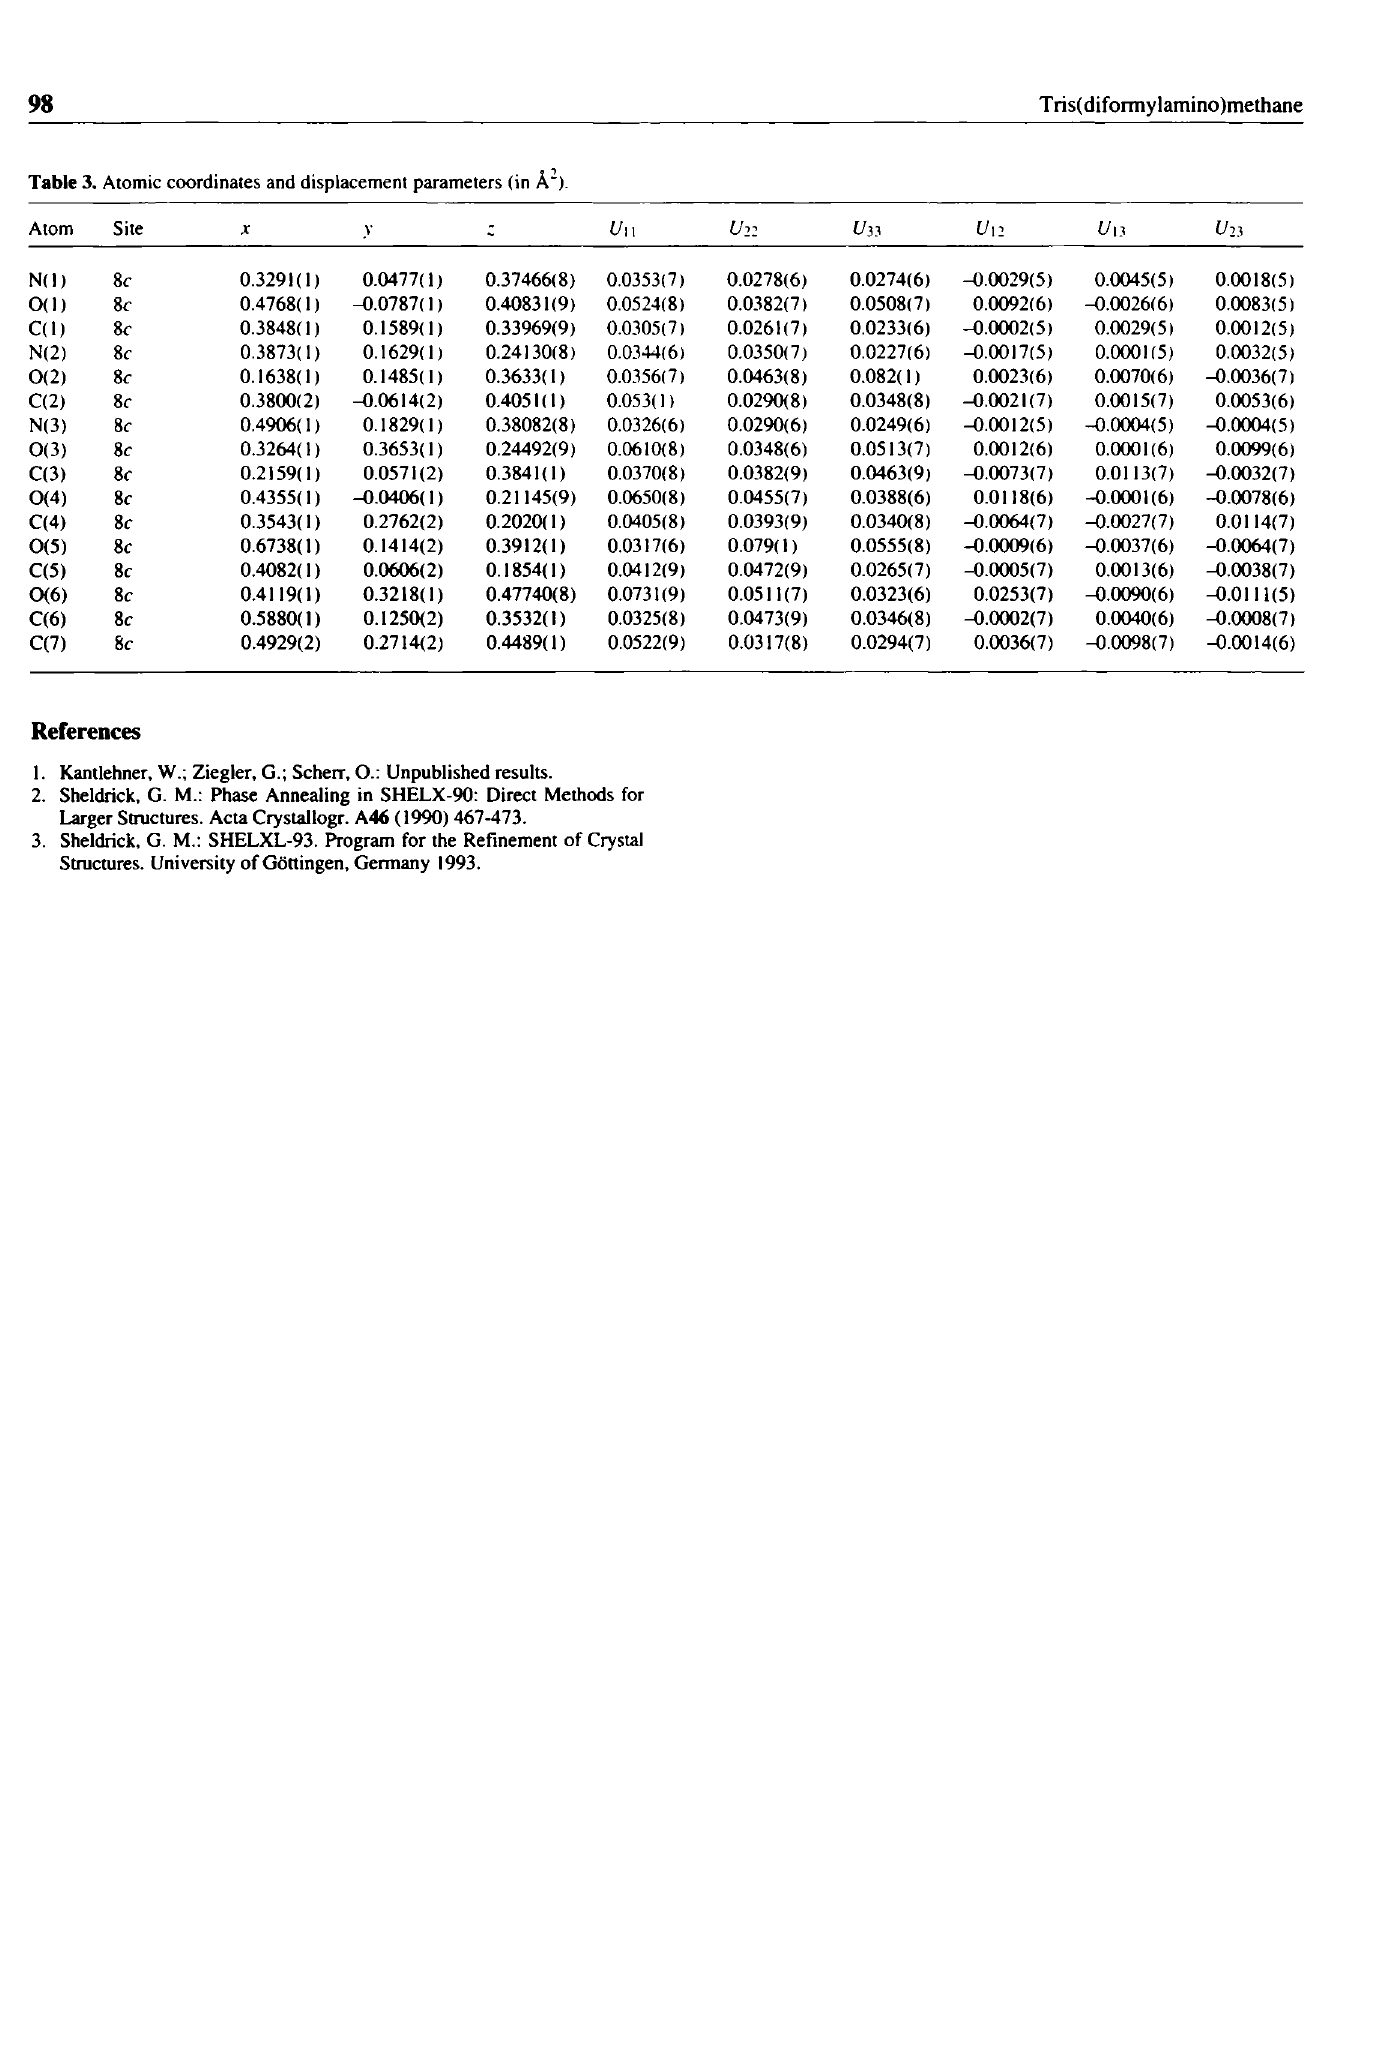
Table 3. Atomic coordinates and displacement parameters (in Ä 2